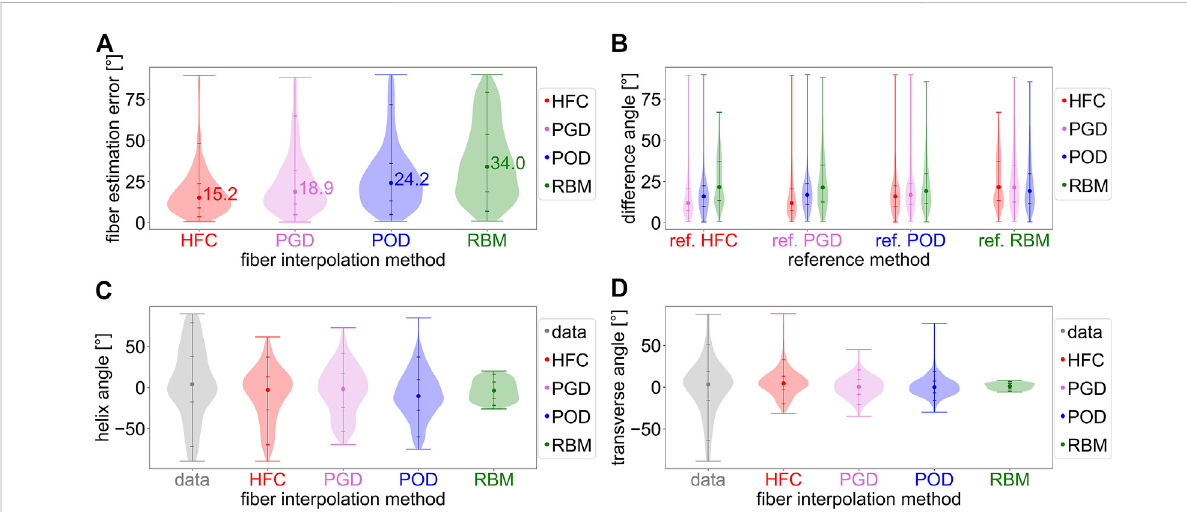
FIGURE 2 Analysis of the interpolated fi ber fi elds from in-vivo cDTI data obtained with the four interpolation methods: the direct tensor interpolation methodusingheat fl uxcoordinates(HFC)inred,thelowrankmodelestimationbasedonProperGeneralizedDecomposition(PGD)inviolet,thelow rank model estimation based on Proper Orthogonal Decomposition (POD) in blue, and the rule-based method adapted to the data (RBM) in green. Subplot (A) shows the absolute angular error distribution and median value for the in-vivo interpolation experiment. The in-vivo cDTI data is interpolatedtoapreviouslyexcludedmid-ventricularshort-axissliceandcomparedtothemeasuredcDTIdata.Subplot (B) analysesthedistributions of the mutual angular difference between the resulting interpolated fi ber fi elds. The reference fi ber fi eld is noted as label on the horizontal axis. Subplots (C,D) depict the distributions of the helix and transverse angle obtained from the data (gray) and the interpolated fi ber fi elds.